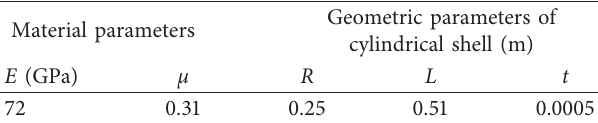
Table 1: Geometric and material parameters of the cylindrical